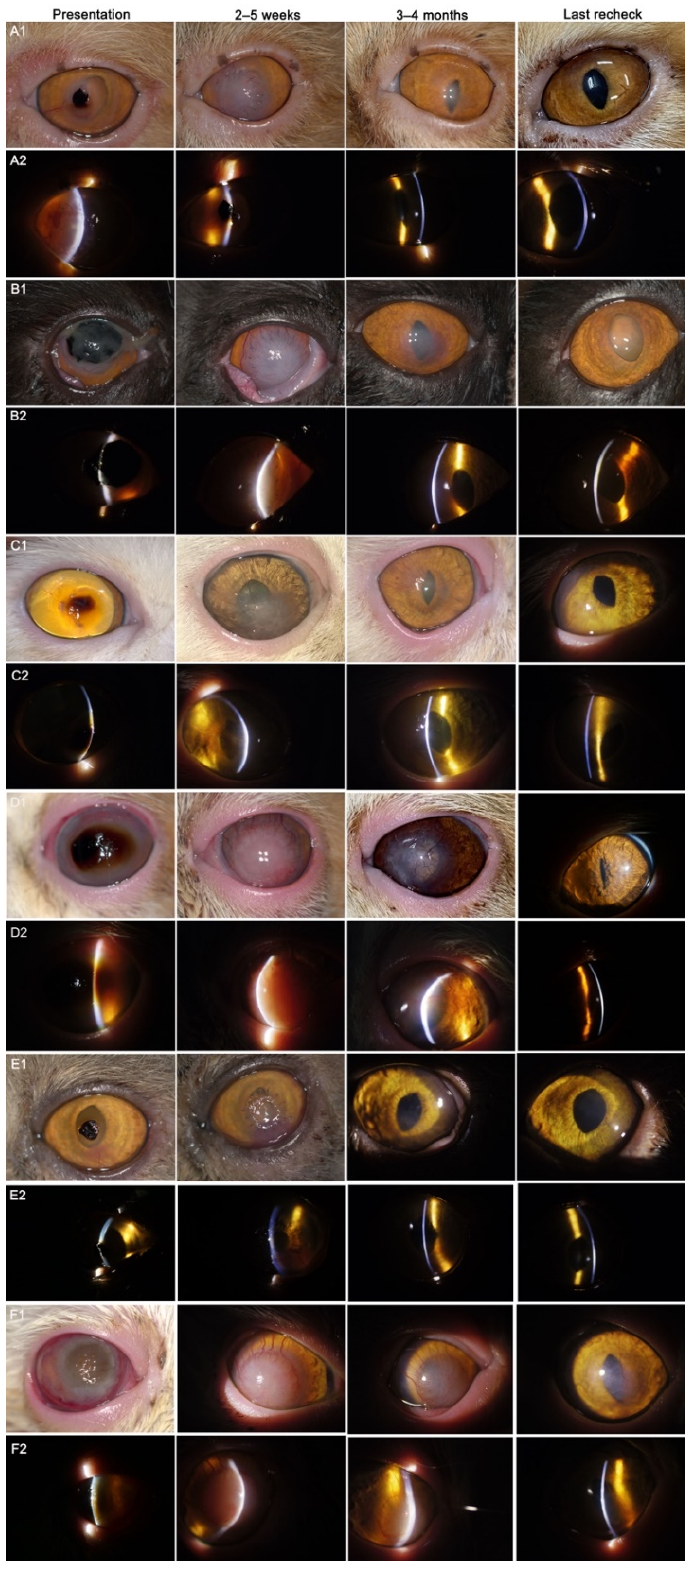
Figure 2. Photographic records of some cases were included in the present study. The first column is at presentation; the second column is 2–5 weeks after keratoplasty; the third column is 3–4 months after keratoplasty; and the fourth column is at the last recheck. ( A1 , B1 , C1 , D1 , E1 and F1 ) By camera; ( A2 , B2 , C2 , D2 , E2 and F2 ) By slit-lamp biomicroscopy; ( A1 – F2 ) Case number: 1, 2, 6, 18, 24 and